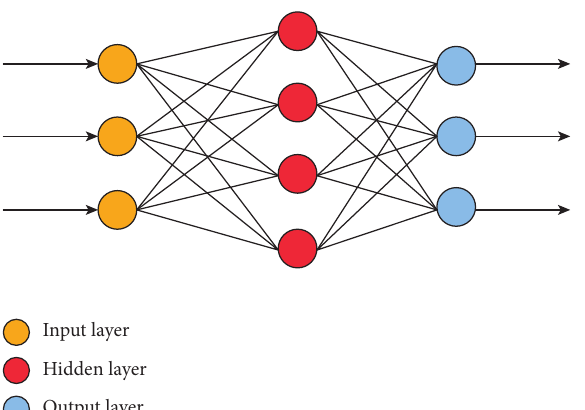
Figure 3: Architecture of artificial neural network (ANN) (adopted from [56]).